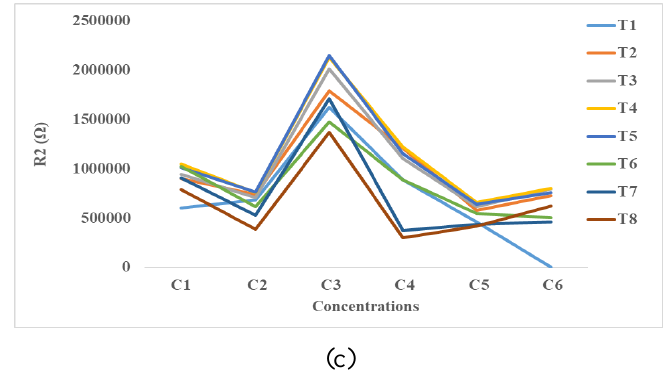
Figure 12. Equivalent electrical circuit including: ( a ) capacitance, ( b ) series resistance and ( c ) parallel resistance/impedance.